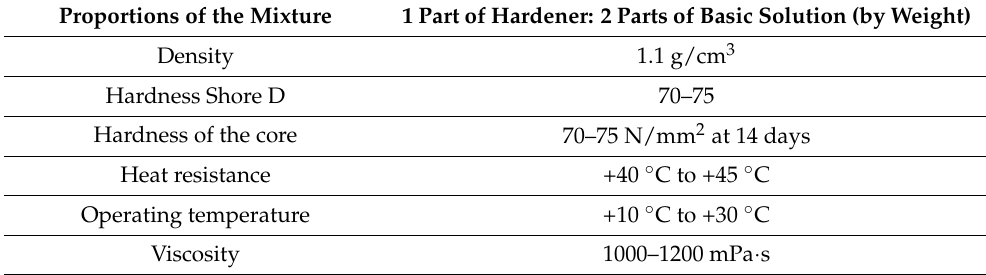
Table 1. Main characteristics of the used epoxy